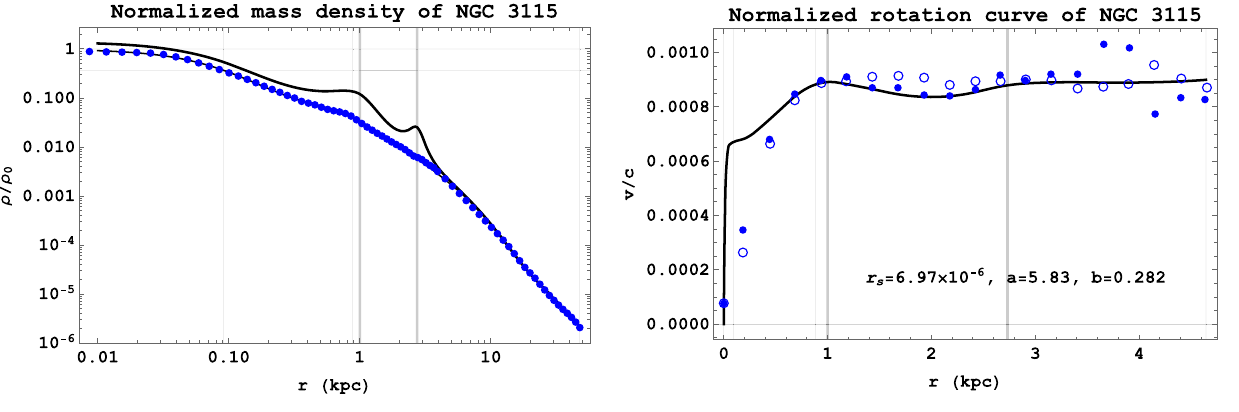
Fig. 10 The thin line in the left-hand side graphic shows the mass den- sity profile fitted to the observed luminosity profile of NGC 3115, listed by Capaccioli [38] and represented by dots. The thick continuous line shows the mass density corrected for the high mass-to-light ratio popu- lation. The line in the right-hand side shows the rotation curve fitted to the experimental values listed by Rubin et al. [37], represented by dots